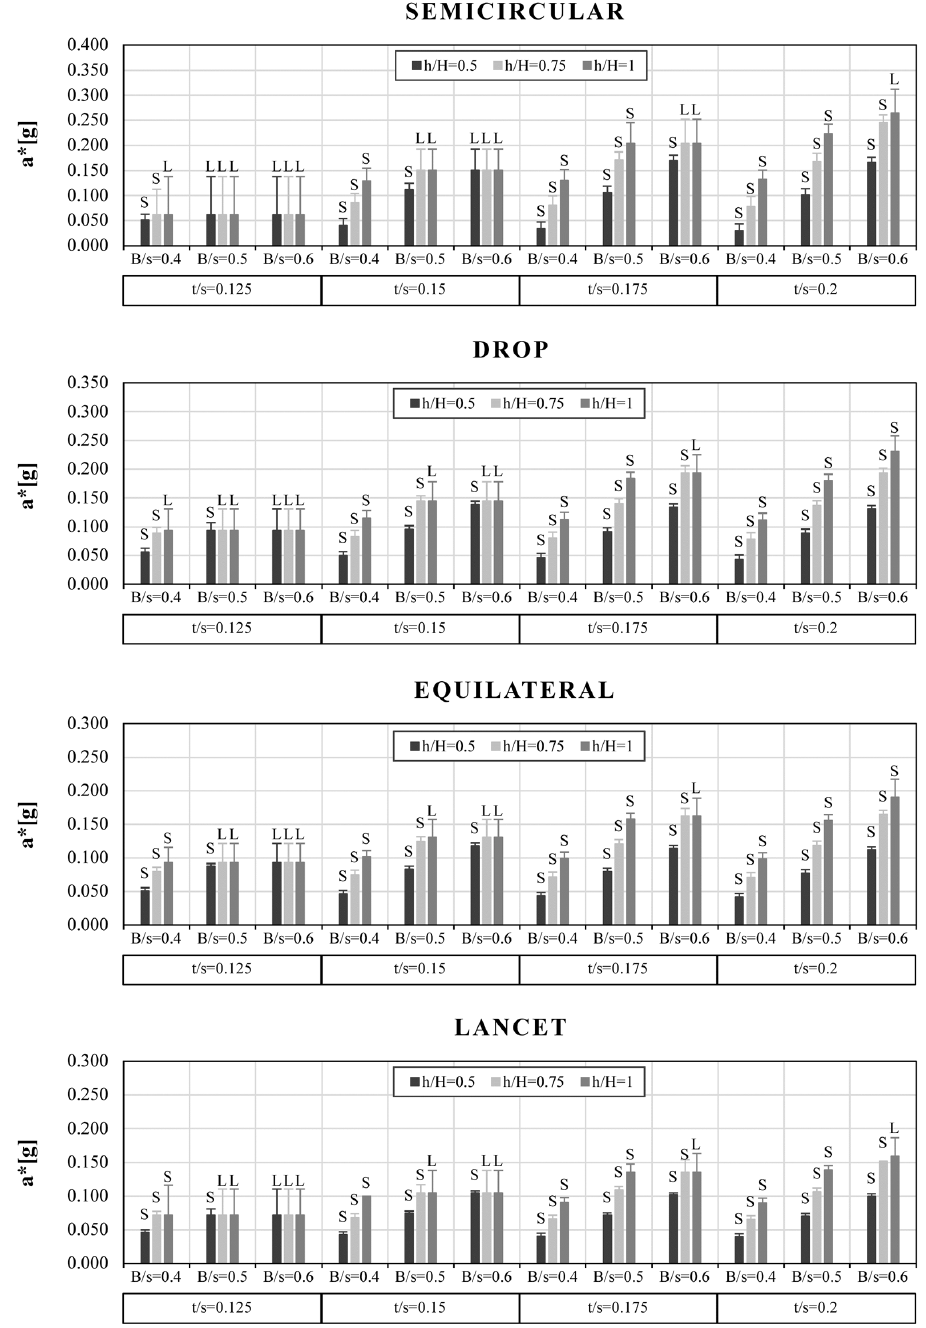
Figure 18. Values of a* [g] of (RE) buttressed arches, for each considered eccentricity, t/s ratio, h/H configuration and B/s value. Local mechanism (L) or Semi-global mechanism (S) are highlighted.